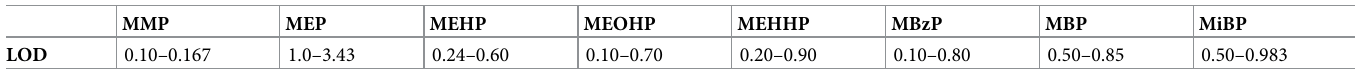
Table 2. Range of limits of detection for phthalate metabolites (ng/mL) measured in urine samples from common bottlenose dolphins sampled during health assessments conducted in Sarasota Bay, FL, USA (2010–2019).